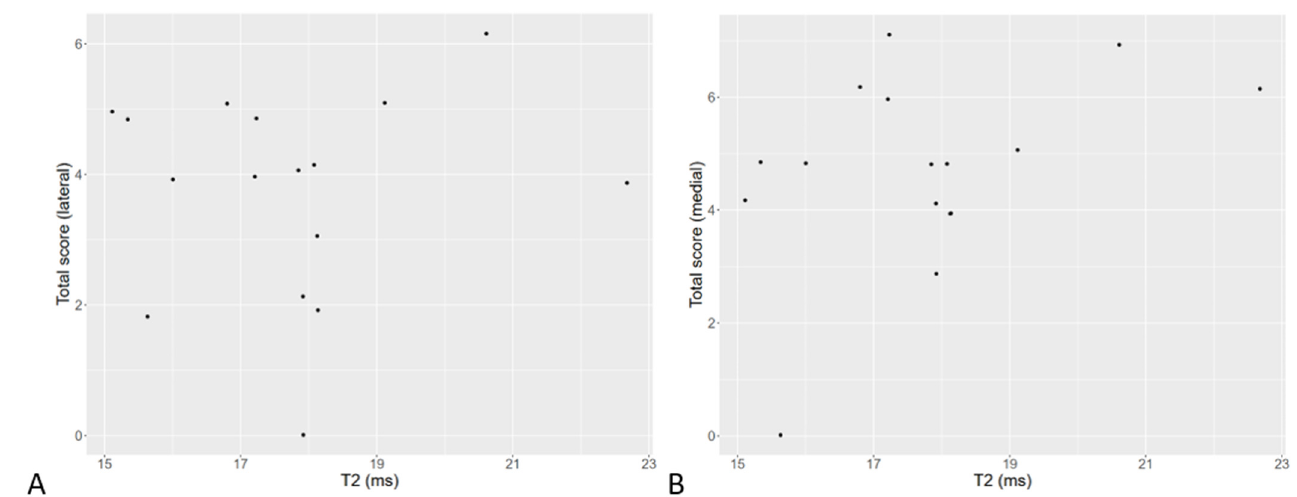
Figure 6. T2 relaxation time versus total histological score in lateral ( A ) and medial ( B ) menisci. There was no significant correlation between T2 values and histological scores.